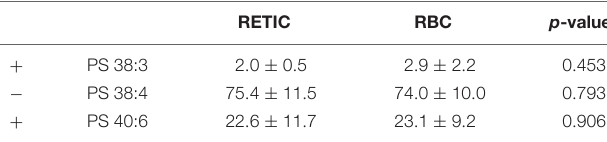
TABLE 6 | PS subclasses in Retics and RBCs subjected to lipidomics